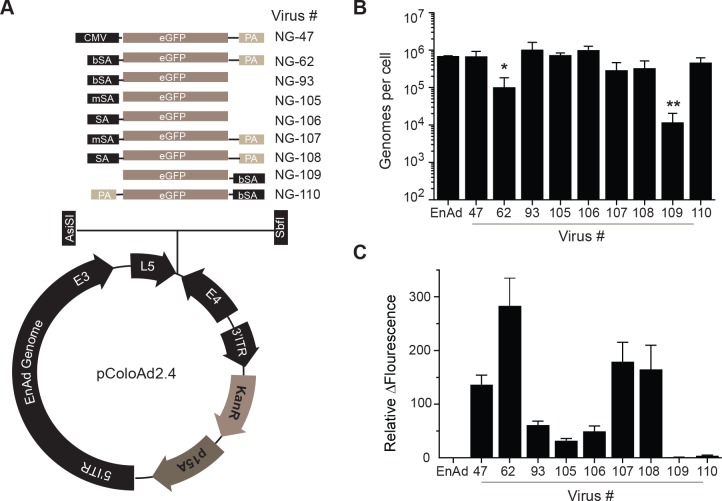
Characterisation of gene expression and viral activity in vitro using a GFP reporter virus library.(A) Schematics of GFP reporter virus transgene cassettes inserted into the pColoAd2.4 vector. (B) Viral genomes detected in the supernatants of HT-29 cells infected for 72hrs with 1ppc of enadenotucirev or GFP encoding viruses quantified by qPCR. Graph shows genomes produced per cell plotted as mean ± SD (n = 3 independent experiments, *P<0.05, **P<0.005 one-way Anova). (C) Quantification of GFP fluorescence in HT-29 cells infected as in (B). Graph shows change in fluorescence relative to uninfected control cells plotted as mean ± SD (n = 3 independent experiments).